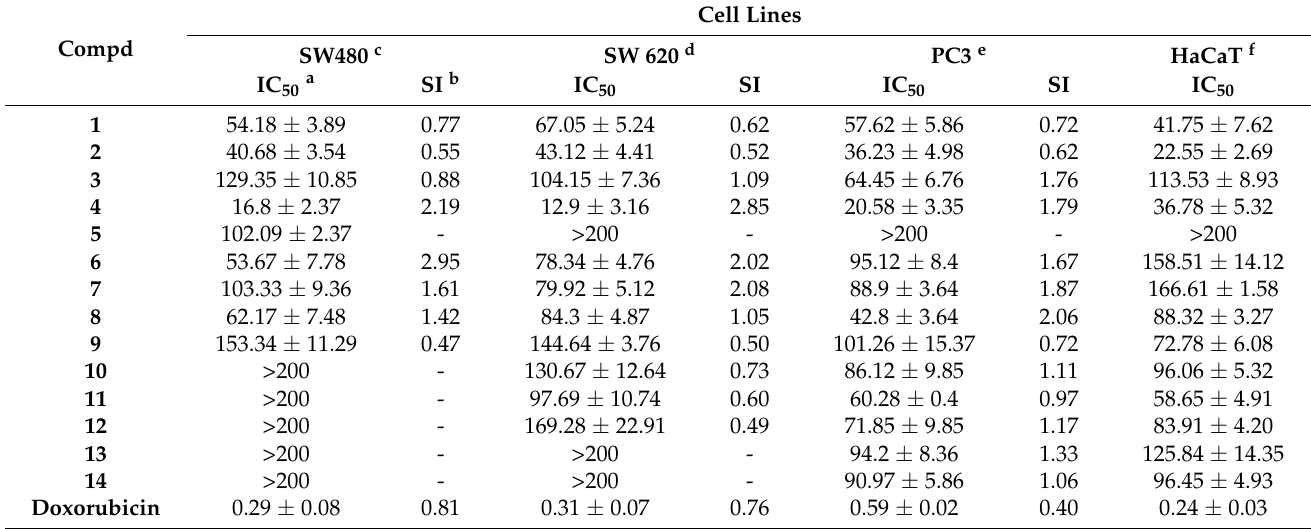
Table 1. Cytotoxic activity IC 50 ( µ M) of compounds 1 – 14 was estimated by the MTT assay. Data are expressed as the mean ±